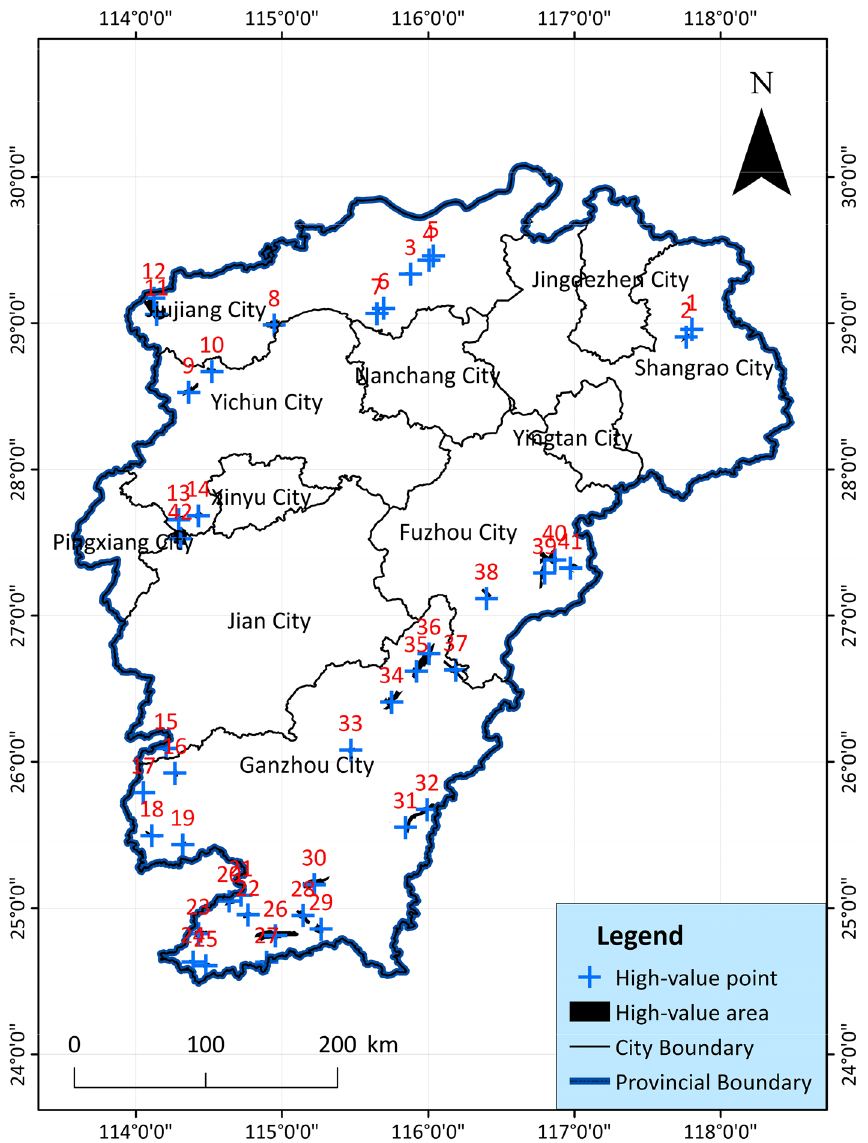
Figure 16. Distribution map of comprehensive evaluation of geothermal resource potential and distribution of high value points in Jiangxi Province, showing the percentage ranking for each